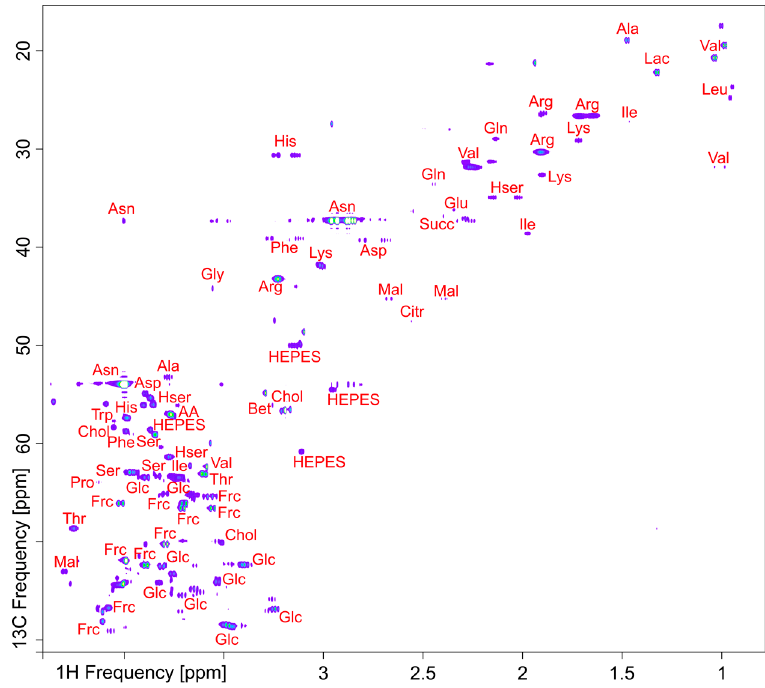
Figure 1. Multi-dimensional 1 H- 13 C NMR spectrum of aqueous extracts from Medicago sativa seedlings illustrating a typical complement of metabolites observed in untargeted NMR.